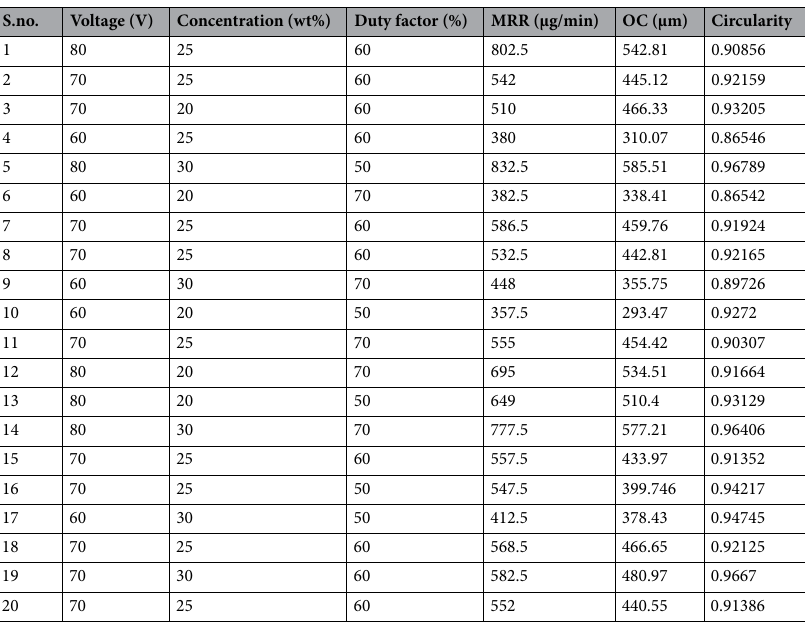
Table 2. FCC-RSM parametric layout with machining characteristics.